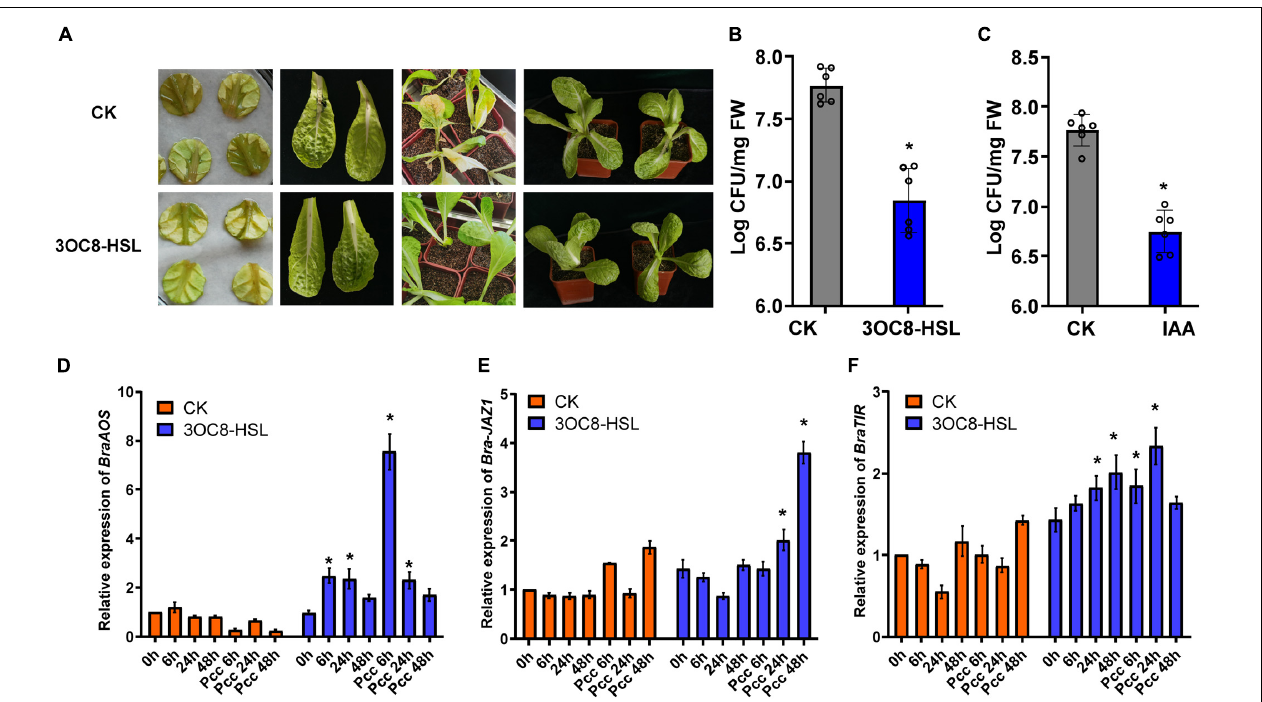
FIGURE 8 | (A) Symptoms of Pcc infection in Chinese cabbage. The top line is untreated Chinese cabbage leaves inoculated with Pcc , and the bottom line is 3OC8 pretreated leaves inoculated with Pcc. (B) AHL priming effect in Chinese cabbage. The proliferation of Pcc in the leaves of Chinese cabbage (grown in pot) in which the roots were pretreated with 10 µ M 3OC8-HSL for 48 h and the leaves were subsequently spray-inoculated with 10 7 CFU/mL Pcc . (C) IAA priming effect in Chinese cabbage. The proliferation of Pcc in the leaves of Chinese cabbage (grown in pot) in which the roots were pretreated with 10 µ M IAA compound for 48 h and the leaves were subsequently spray-inoculated with 10 7 CFU/mL Pcc . (D–F) Expressions of BraAOS , BraJAZ1, and BraTIR1 induced by 10 µ M IAA. At least five independent experiments were performed, each of which with three technical repeats. Asterisks indicate a statistically significant difference between the AHL-pretreated and the water-treated plants (ANOVA test, * P < 0.05). Values are means ± SD of five independent